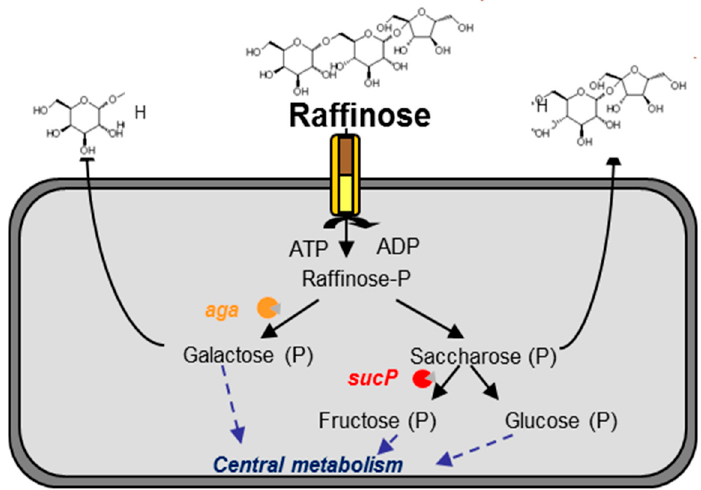
Figure 2. Putative raffinose metabolism in the environmental L. lactis subsp. lactis A12 strain.